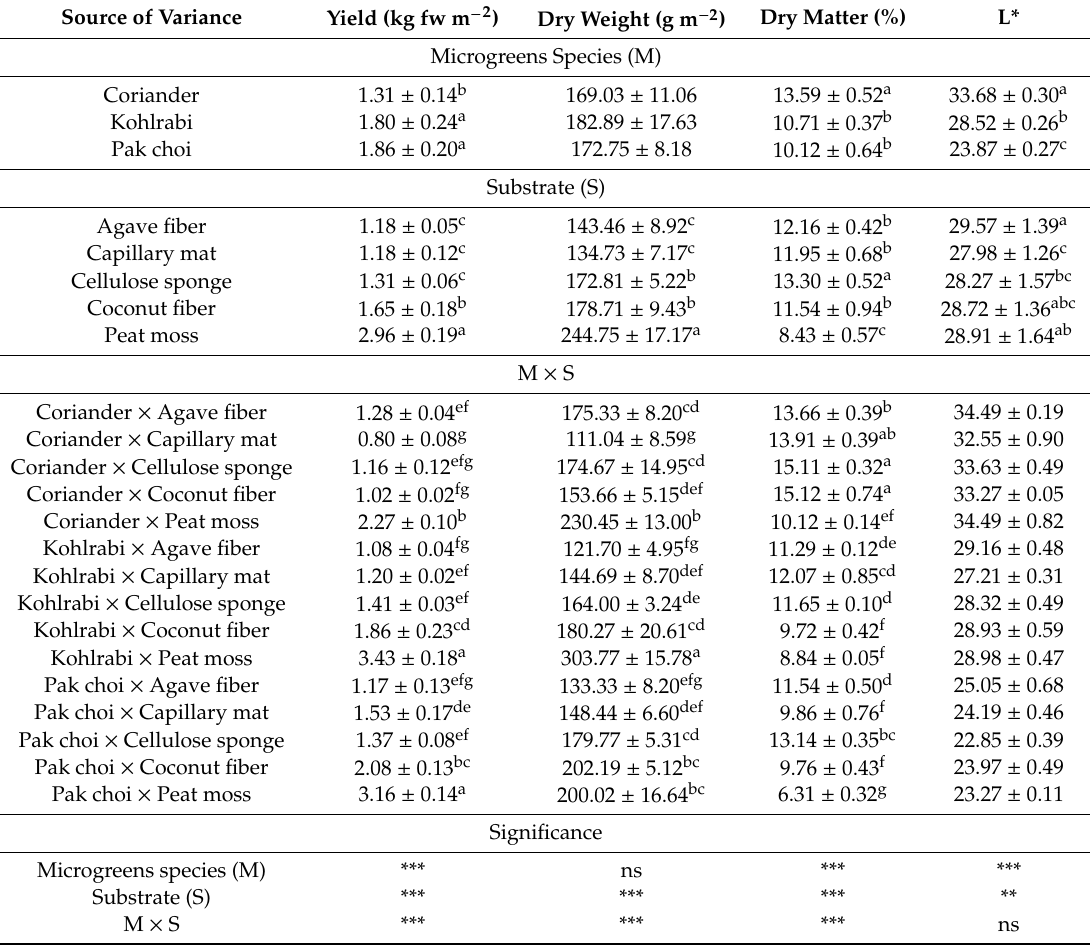
Table 2. Fresh and dry yield, dry matter content and canopy lightness (L*) of coriander, kohlrabi and pak choi substrates grown on natural fiber and synthetic substrates under a controlled environment. All data are expressed as mean ± standard error, n =